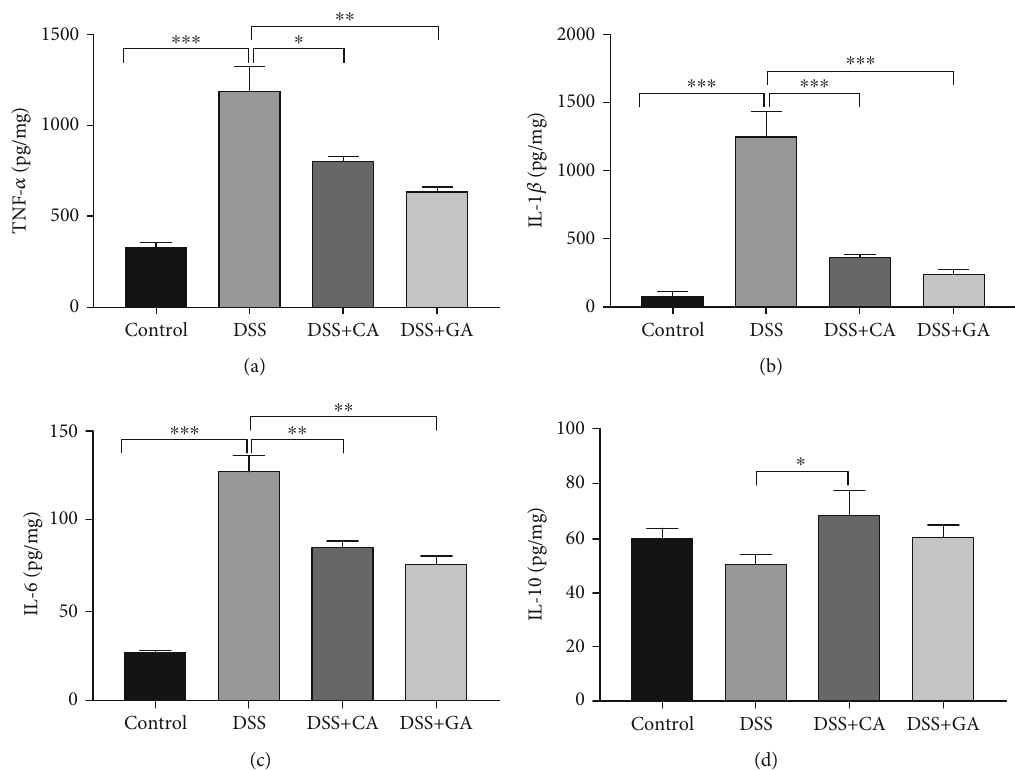
Figure 2: Local liver cytokine production in IBD mice and the e ff ect of cecropin A and antibiotic treatment in DSS-treated mice. Protein concentrations of TNF- α , IL-1 β , IL-6, and IL-10 per milligram of liver tissue by ELISA in the DSS group ( n = 9 ), control group ( n = 9 ), cecropin A group (CA, n = 9 ), and gentamicin group (GA, n = 9 ). The data were analyzed by one-way ANOVA and presented as the mean ± SEM with ∗ P < 0 : 05 , ∗∗ P < 0 : 01 , ∗∗∗ P < 0 : 001 versus